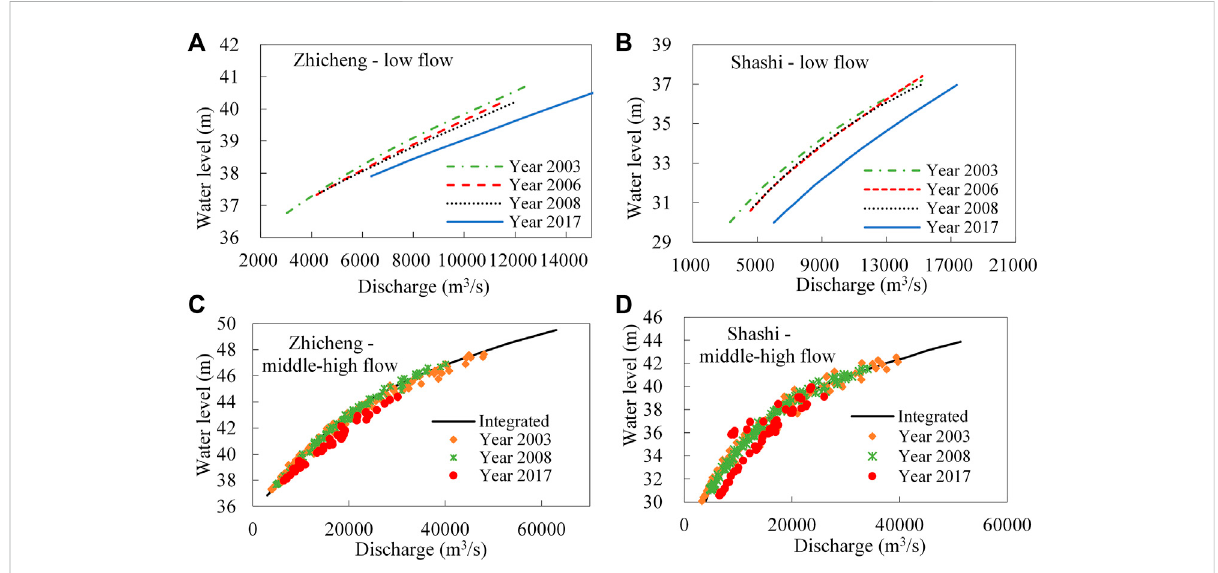
FIGURE 5 Thestage-dischargerelationship(basedonobservations): (A) Zhichengatlow fl ow; (B) Shashiatlow fl ow; (C) Zhichengatmiddle-high fl ow; (D) Shashi at middle-high fl ow.